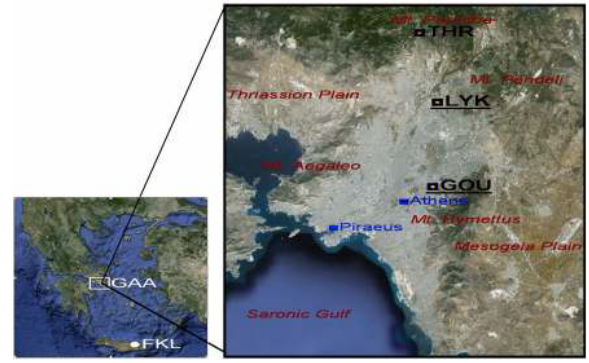
Fig. 1. Map indicating the location of the sampling sites referenced in the